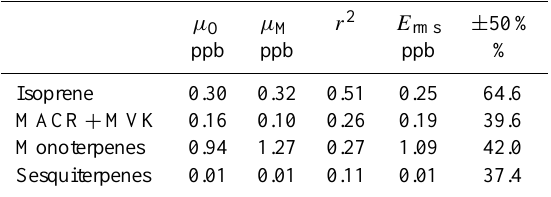
and emissions of monoterpenes and sesquiterpenes. Based Table 2. A comparison of mean mixing ratios from observation ( µ O ) and model output ( µ M ) for the 22 day period. Coefficient of correlation ( r 2 ), root-mean-square error ( E rms ), and the fraction of modelled 30min averages between 50 and 150% of the observed 30min averages are